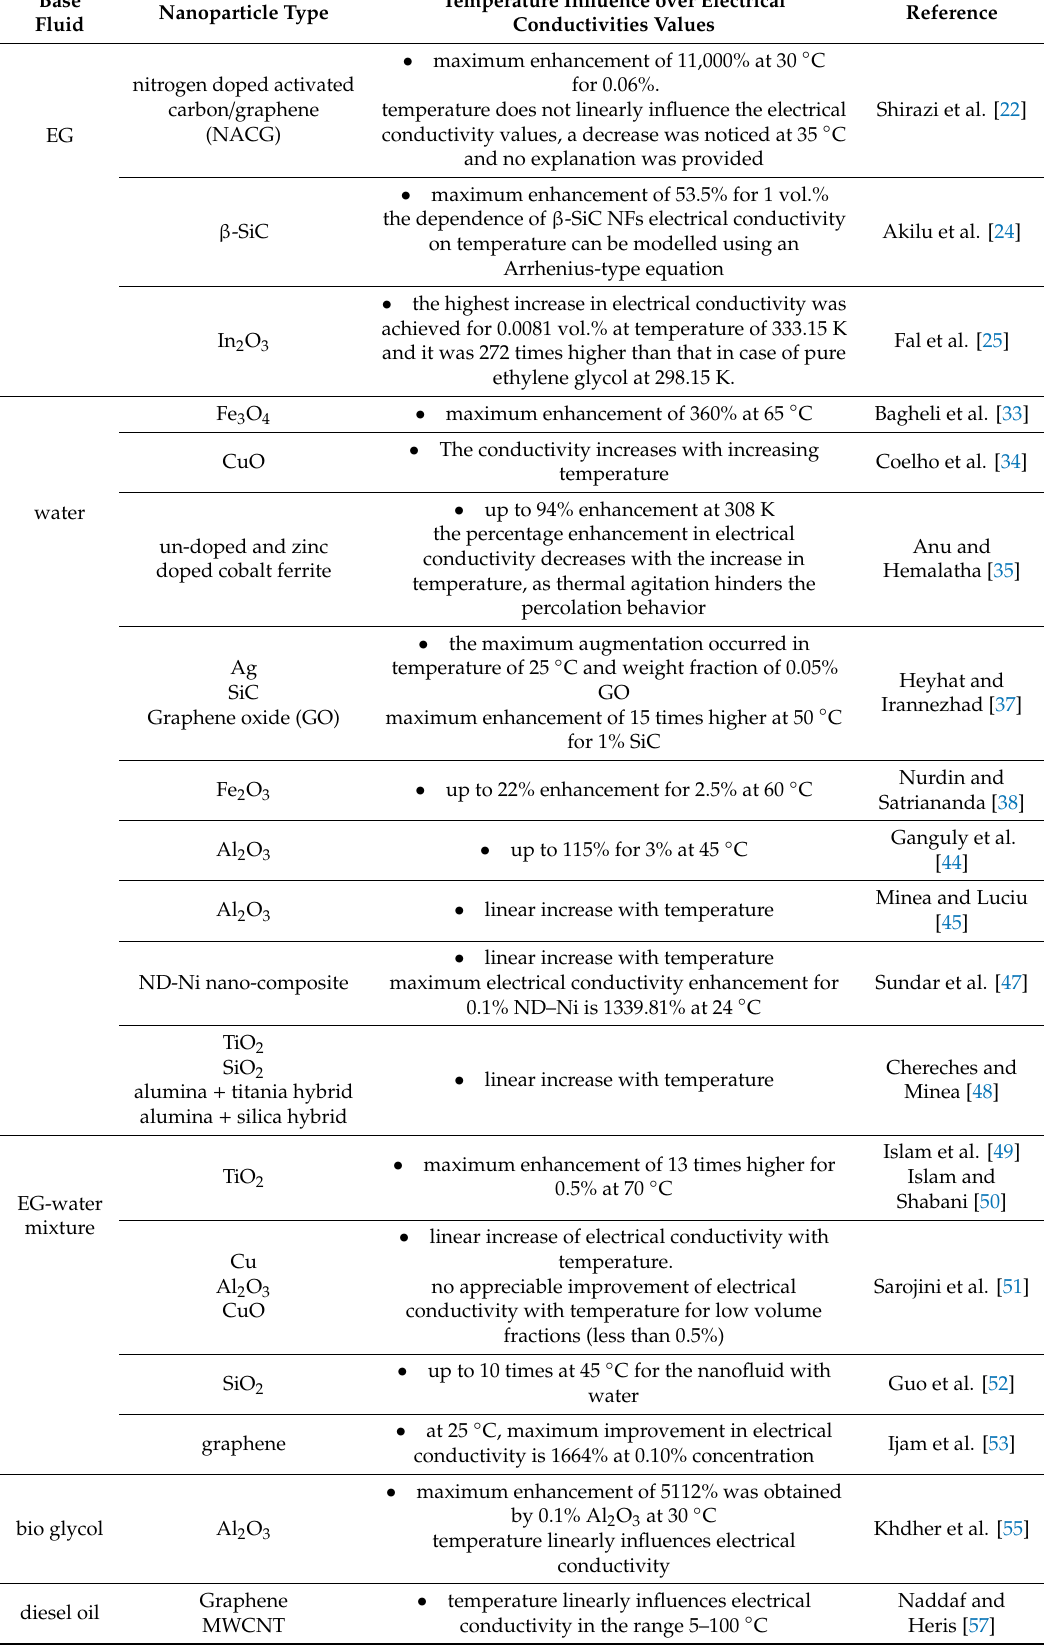
Table 3. Outline of experimental work on electrical conductivity variation with